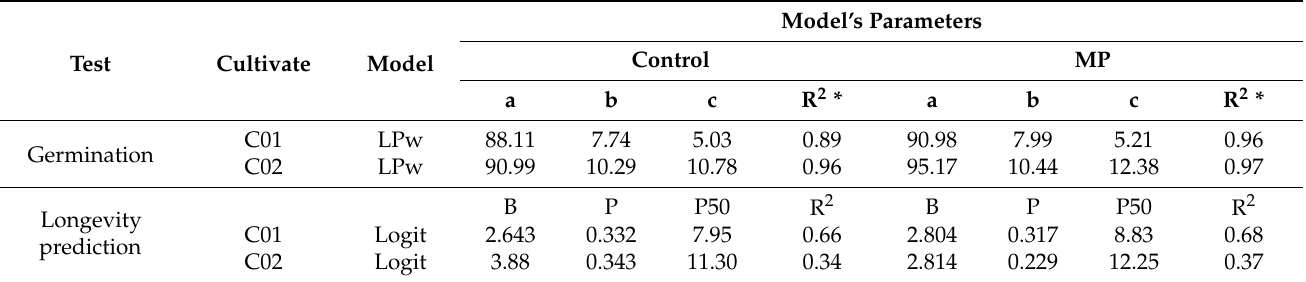
Table 4. Models for adjusting the longevity curve of soybean seeds before and after exposure to magneto-priming (MP).